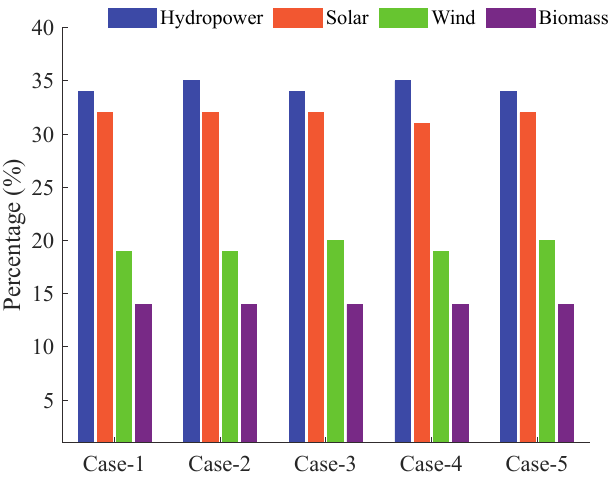
Figure 8. Results of the sensitivity analysis in five cases.